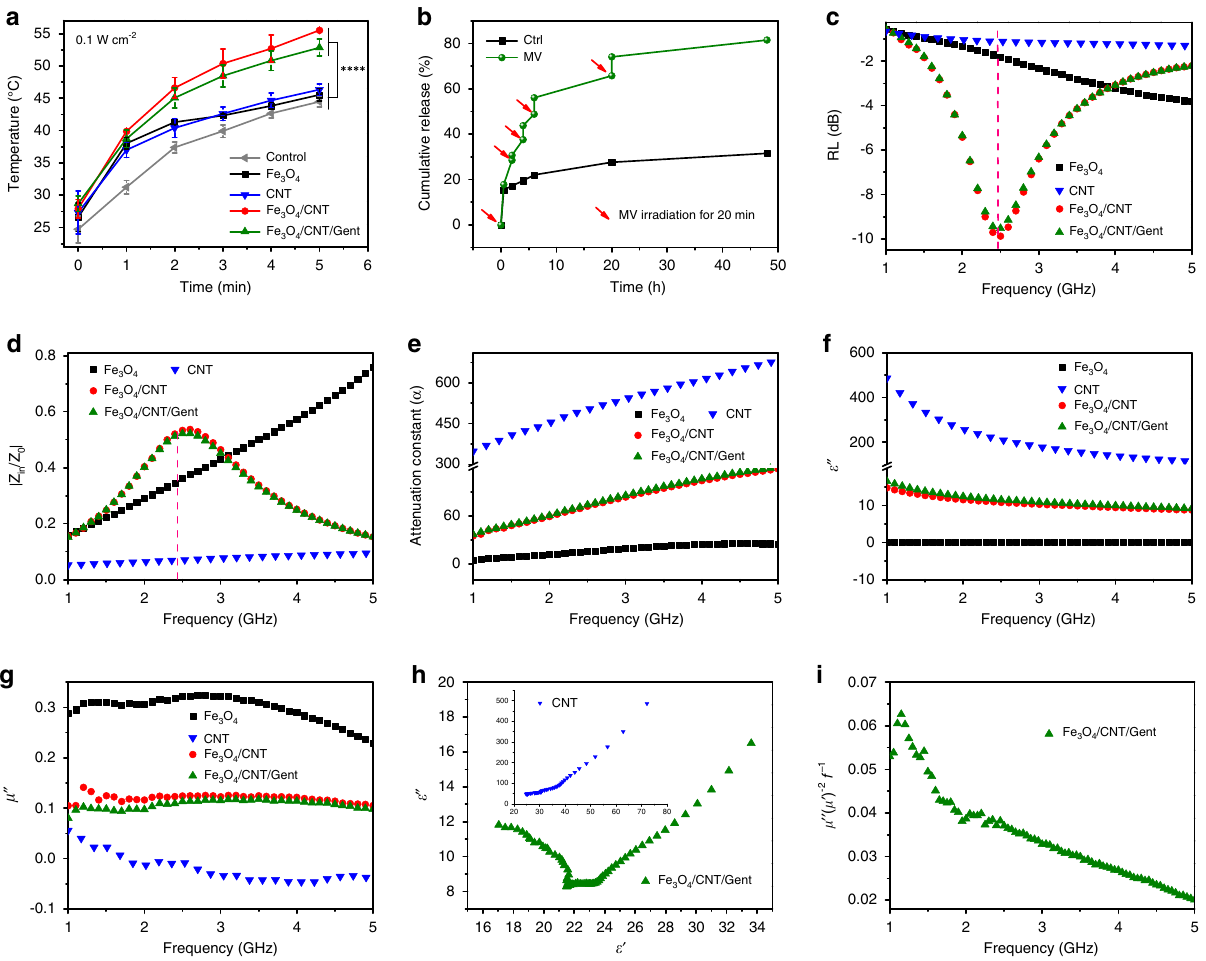
Fig. 3 Mechanism of enhanced microwaveocalortic effect and the thermo-responsive performance. a The microwaveocalortic curves of the Fe 3 O 4 , CNT, Fe 3 O 4 /CNT, and Fe 3 O 4 /CNT/Gent under MV excitation for 5 min. Data are presented as mean ± standard deviations from a representative experiment ( n = 3 independent samples). **** P < 0.0001 analysed by two-way ANOVA with Tukey ’ s multiple comparisons post hoc test. b In vitro Gent release pro fi le from Fe 3 O 4 /CNT/Gent under MV excitation or not. c Re fl ection loss curves of Fe 3 O 4 , CNT, Fe 3 O 4 /CNT, and Fe 3 O 4 /CNT/Gent. d Frequency dependence of relative input impedance (| Z in / Z 0 |). e Frequency dependence of attenuation constant α . Imaginary part of complex permittivity ( f ) and permeability ( g ) of the four samples in the 1 – 5 GHz range. h Plots of ε ′ versus ε ″ for Fe 3 O 4 /CNT/Gent. Inset: plots of ε ′ versus ε ″ for CNT. i Frequency dependence of μ ″ ( μ ′ ) − 2 f − 1 values for Fe fi 3 O 4 /CNT/Gent. Source data are provided as a Source Data